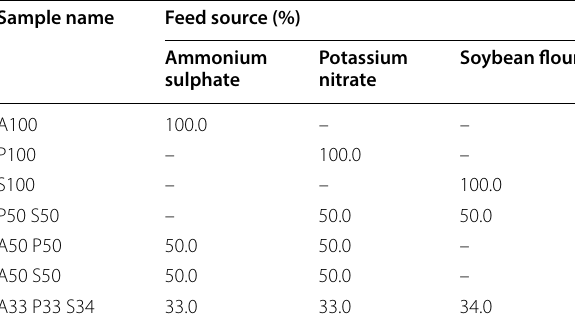
Table 1 Feed source treatments used in this study, the acronym follows the feed source used followed by its composition ratio, as